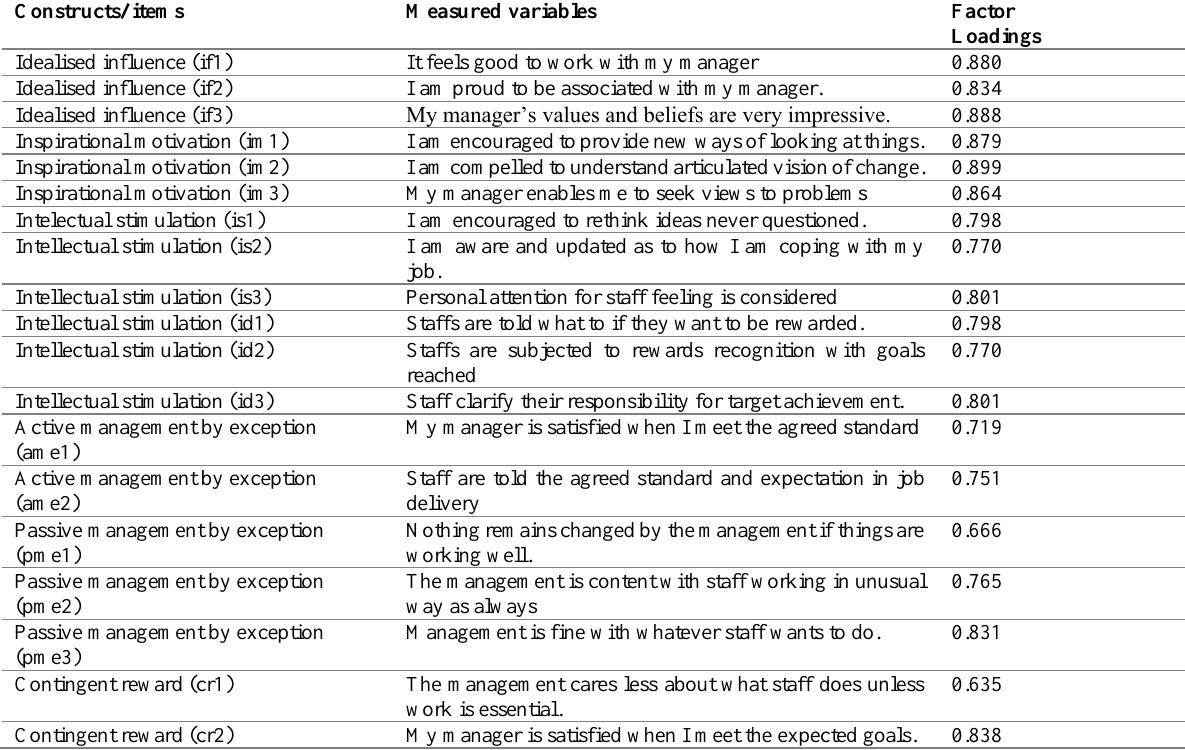
Table 1: Factor Loadings of